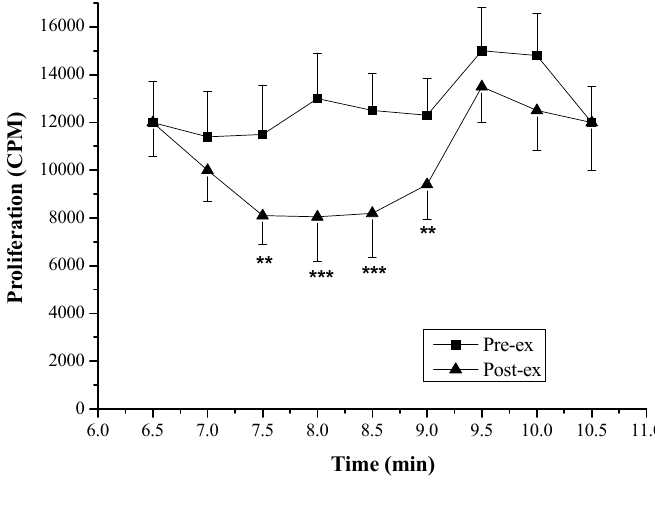
Figure 3. Effects of HPLC eluate obtained from sera on normal mice lymphocyte proliferation. Data are presented as mean ±SD (n = 8). ** P < 0.01, pre-exercise (Pre-ex) vs . post-exercise (Post-ex); *** P <